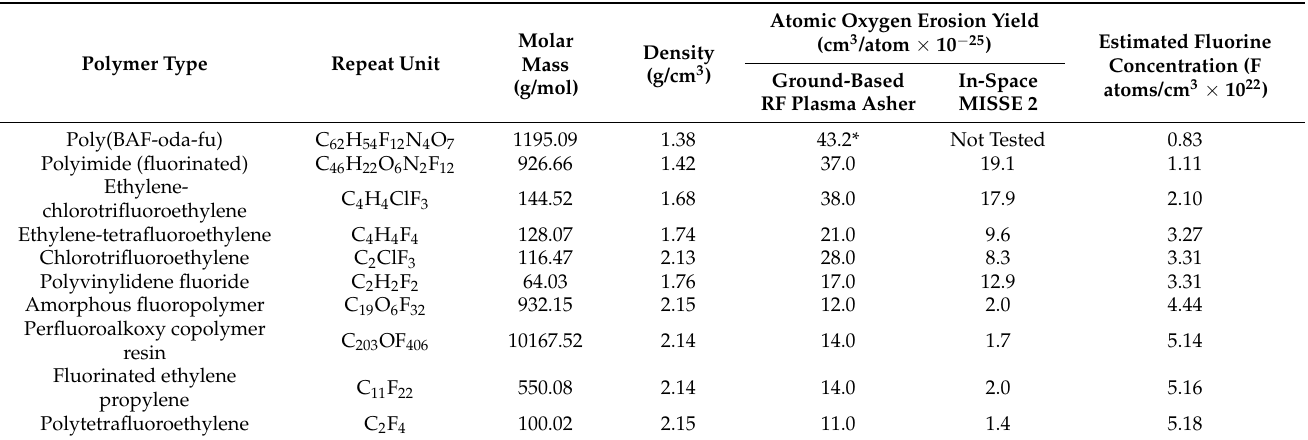
Table 3. Physical Properties, Atomic-Oxygen Erosion Yields, and Estimated Fluorine Concentration for poly(BAF-oda-fu) and Select Fluorinated Polymers Previously Tested by NASA.